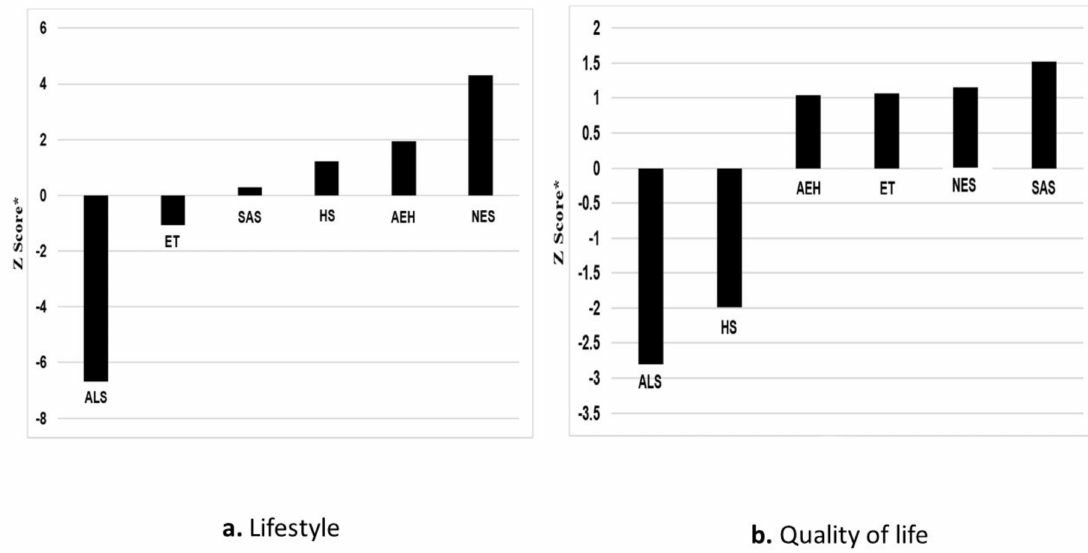
Figure 1. Ranking of students’ lifestyle and quality of life needs by academic discipline ( N = 5443). * A higher negative Z-score indicates higher priority. AEH, Arts, Education, and Humanities; ALS, Agricultural Sciences; HS, Health Sciences; NES, Natural and Exact Sciences; SAS, Social and Administrative Sciences; ET, Engineering and Technology.